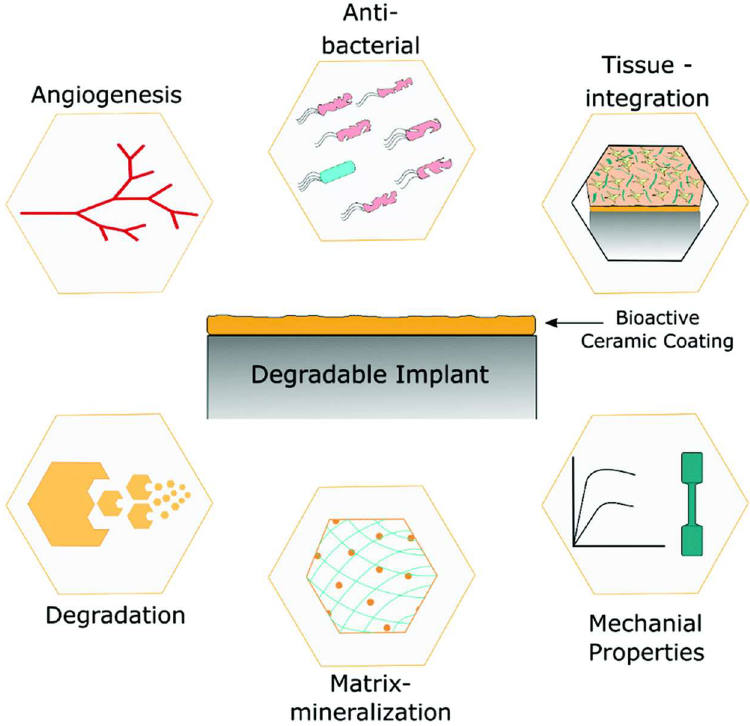
Figure 1. The role of bioactive coated metallic implants as a potential implant material [127]. The qualities of coated implants are superior to those of uncoated metallic implants.